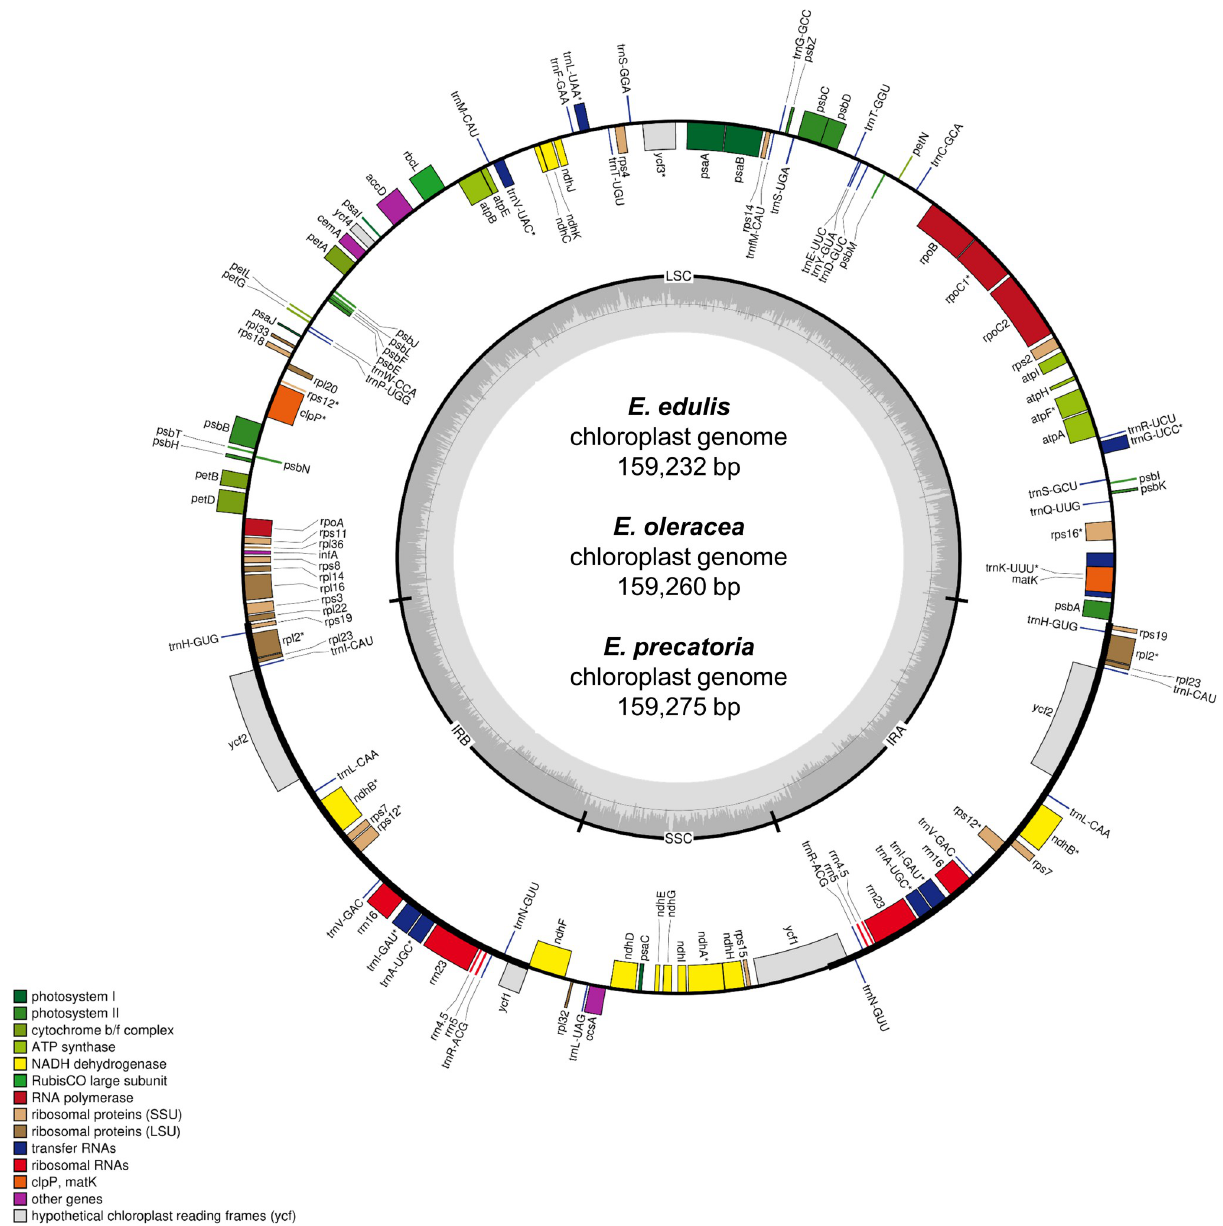
Fig 1. Gene map of the Euterpe edulis , E . oleracea and E . precatoria chloroplast genomes. Genes represented inside the large circle are oriented clockwise and the ones outside are oriented counter clockwise. The different colors represent functional groups, and the darker gray in the inner circle indicates the GC content. The quadripartite structure is also reported as: LSC = Large Single Copy, SSC = Small Single Copy, IRA/IRB = Inverted Repeats A and B. edulis and E . oleracea were 835 bp and 458 bp, respectively, larger than the others. The align- ment revealed that these increases were due to insertions that occurred mainly in intergenic spacers (83.3% of insertions in E . edulis and 100% in E . oleracea ; S2 Table). Although exhibiting high synteny and only a few structural rearrangements in their chloro- plast genome, the most notable divergence among the three Brazilian native species from sub- family Arecoideae was in the length of the LSC, between 40,000 and 50,000 bp (Fig 2). A high